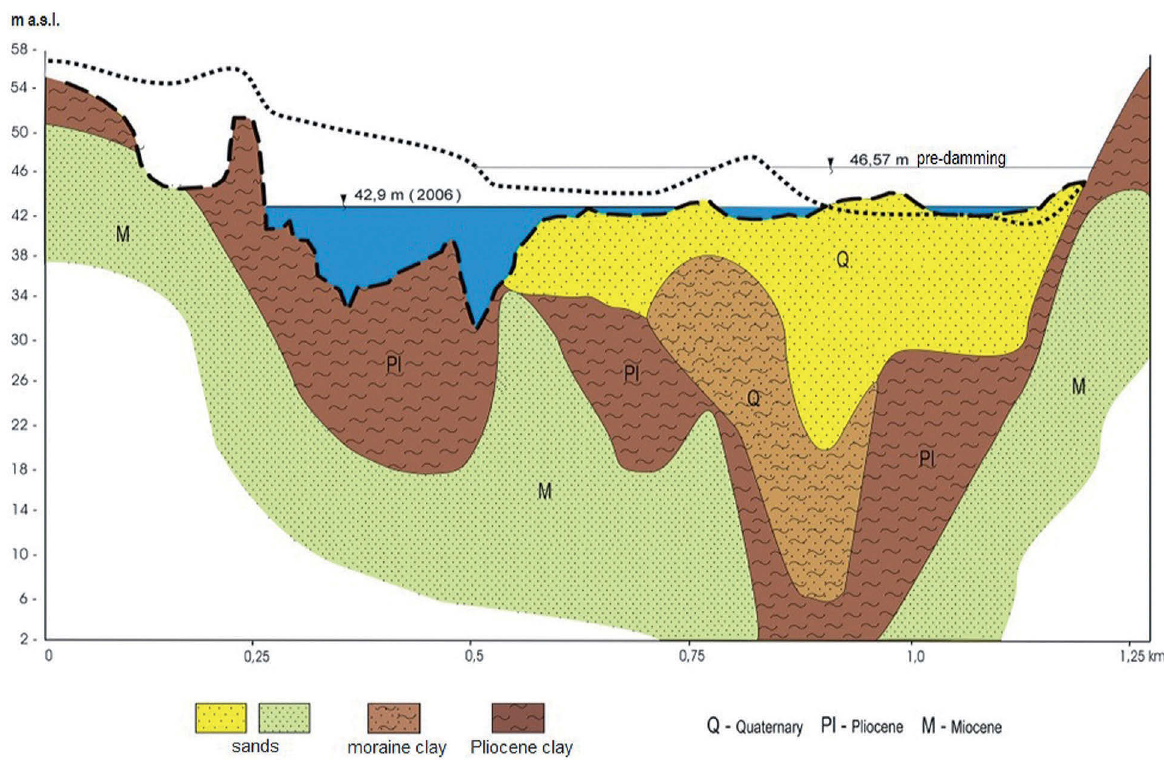
Fig. 4. The geological cross-section of the Vistula valley at the Włocławek dam according to Fąferek (1960 – simplified) with the present channel bed